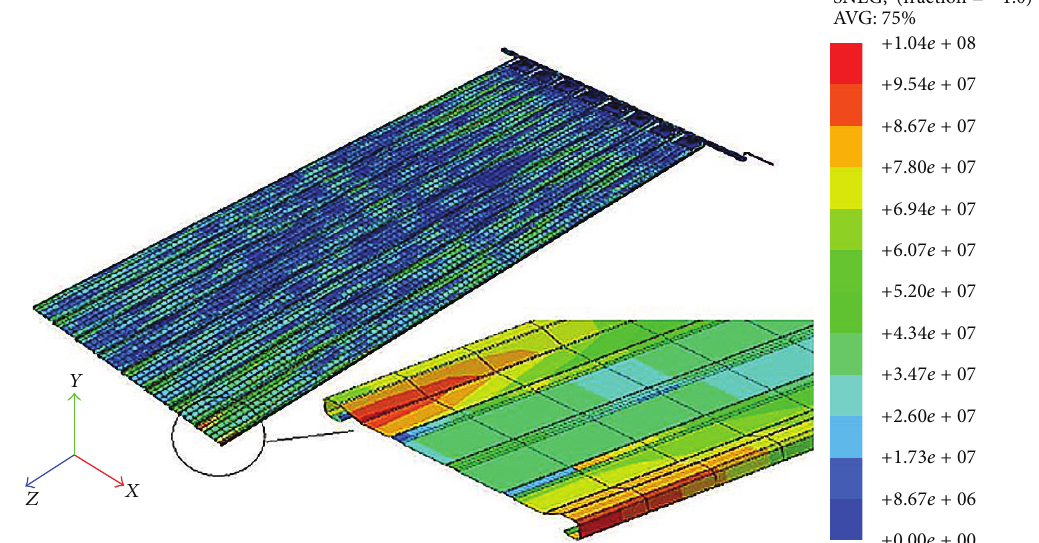
Figure 13: Maximum dynamic von Mises stresses in the collecting plate.